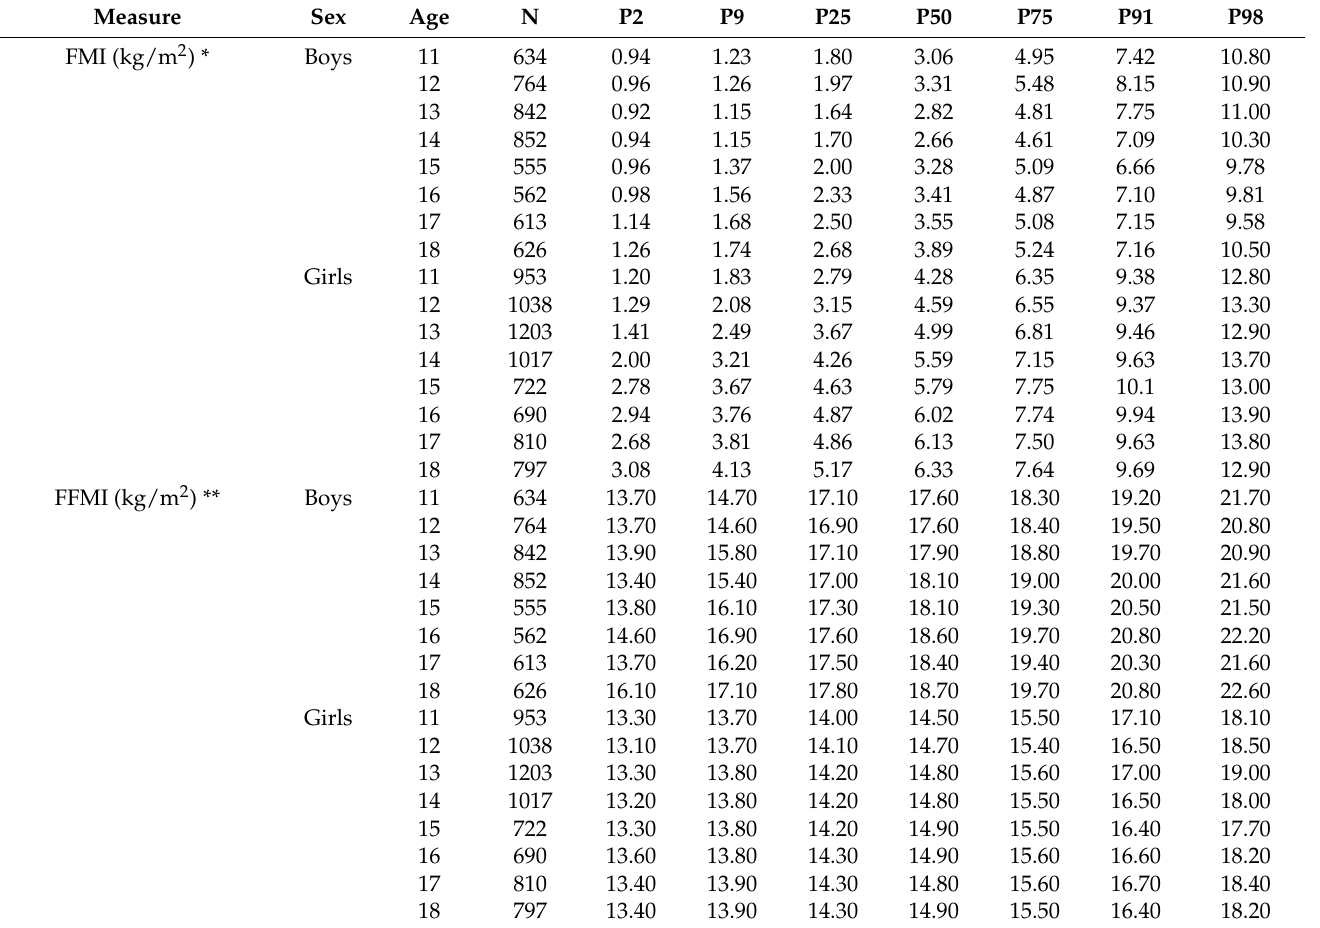
Table 2. Sex-specific and age-specific reference data for FMI and FFMI of the study participants ( n = 12,678). Measure Sex Age N P2 FMI (kg/m 2 ) *